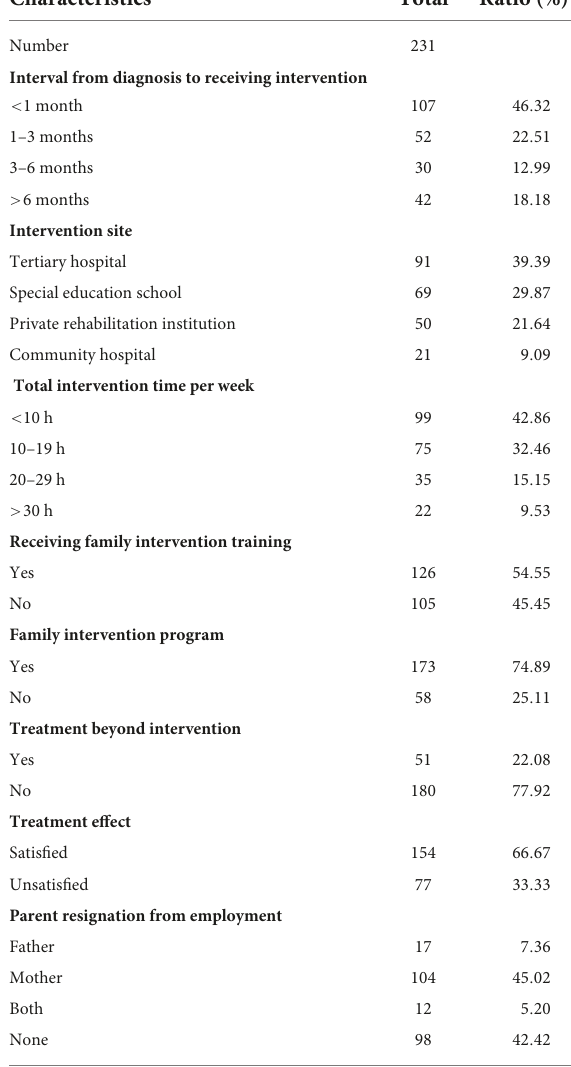
TABLE 2 The rehabilitation intervention status of children with autism spectrum disorder (ASD) in Guizhou province ( n , %).